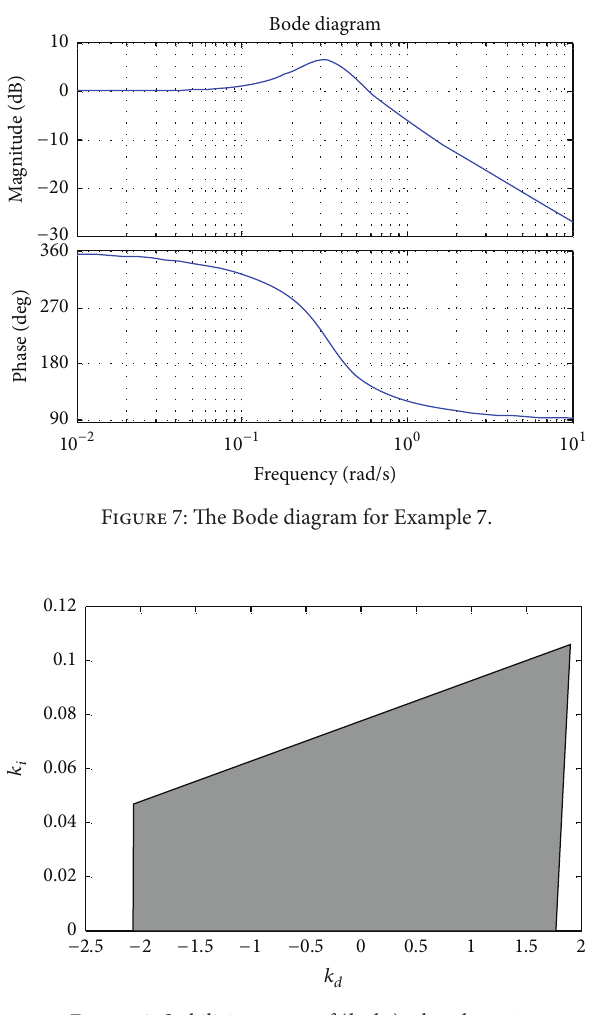
Figure 8: Stabilizing range of (𝑘 𝑖 , 𝑘 𝑑 ) when 𝑘 𝑝 = 1 .